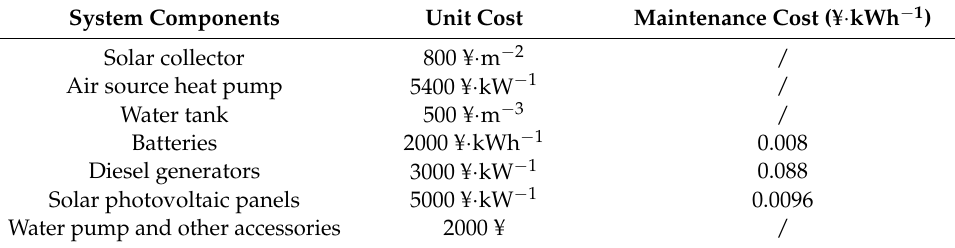
Table 4. Cost of each